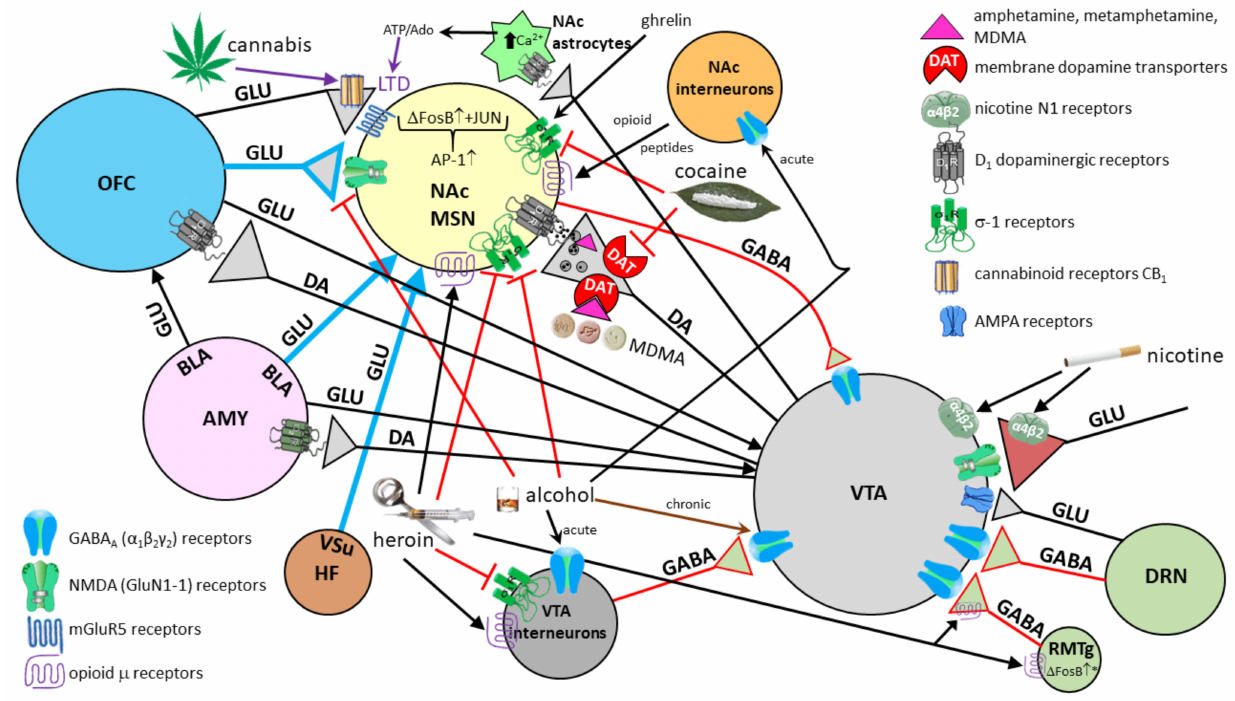
Figure 14. Schematic drawing of the main sites and mechanisms of action of some common addictive drugs on the brain reward system: reward learning and motivation are strongly influenced by the amygdala. Thick blue arrows from OFC, AMY, and HF to NAc convey contextual information associated with the addictive substance and contribute to relapse. Although many addictive substances directly stimulate the release of dopamine from neurons in the VTA that are projected into the NAc, it must not be forgotten that the same effect (activation of VTA) with drug-related stimuli can be achieved indirectly through projections from the amygdala to the PFC and then from PFC to VTA [265]. In a state of developed dependence, the reward system is active, but the usual (normal) reward can no longer activate it. This state of motivational toxicity is expressed in hardened addicts. It is manifested by a lack of interest in career, social and sexual relations, financial status and increased engagement in the procurement and consumption of drugs. The diagram does not show the efferent projections of NAc that go to the basal ganglia and ventral pallidum. Neurons of the ventral pallidum are projecting through the mediodorsal nucleus of the thalamus into the PFC and striatum, and additional projections go into the RMTg, the compact part of the substantia nigra (SNc), and the reticular formation of the pons. Not shown are glutamatergic projections from the thalamus and ACC into Nac, as well as projections of NAc and ventral pallidum into the lateral hypothalamus. AMPA— α -amino-3-hydroxy-5-methyl-4-isoxazolepropionic acid; AMY—amygdala; AP-1—transcription factor activating protein 1; ATP/Ado—adenosine triphosphate/adenosine; BLA—basolateral nucleus of amigdala; DA—dopamine; DRN— dorsal raphe nucleus; ∆ FosB & JUN—truncated member of the Fos family of transcription factors and JUN protein ( ∆ FosB ↑ * in RMTg applies only to psychostimulants); GABA— γ -aminobutyric acid; GLU—glutamate; HF—hippocampal formation; LTD—long-term depression; MDMA—3,4-methylenedioxymethamphetamine (ecstasy); NAc MSN—medium spiny neurons in nucleus accumbens septi; OFC—orbitofrontal cortex; RMTg—rostromedial tegmental nucleus; VSu—ventral subiculum; VTA—ventral tegmental area. See text for